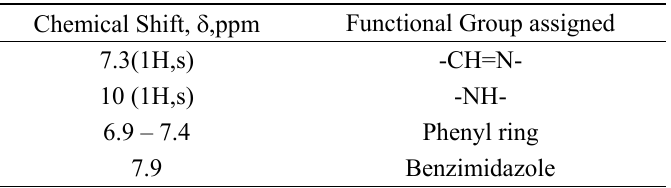
Table 4. 1 H NMR data of Schiff